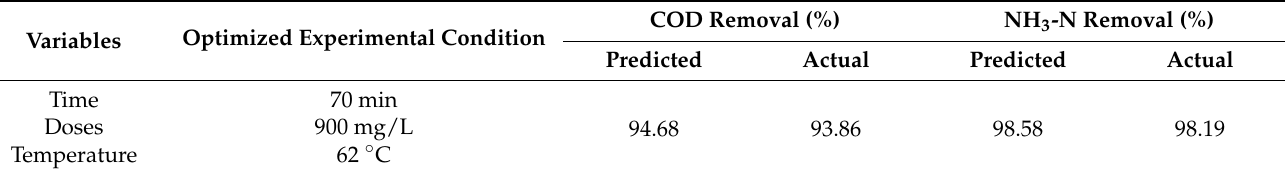
Table 6. Optimized experimental condition for removing COD and NH 3 -N from SPRE using FeSO 4 · 7H 2 O as a coagulant.